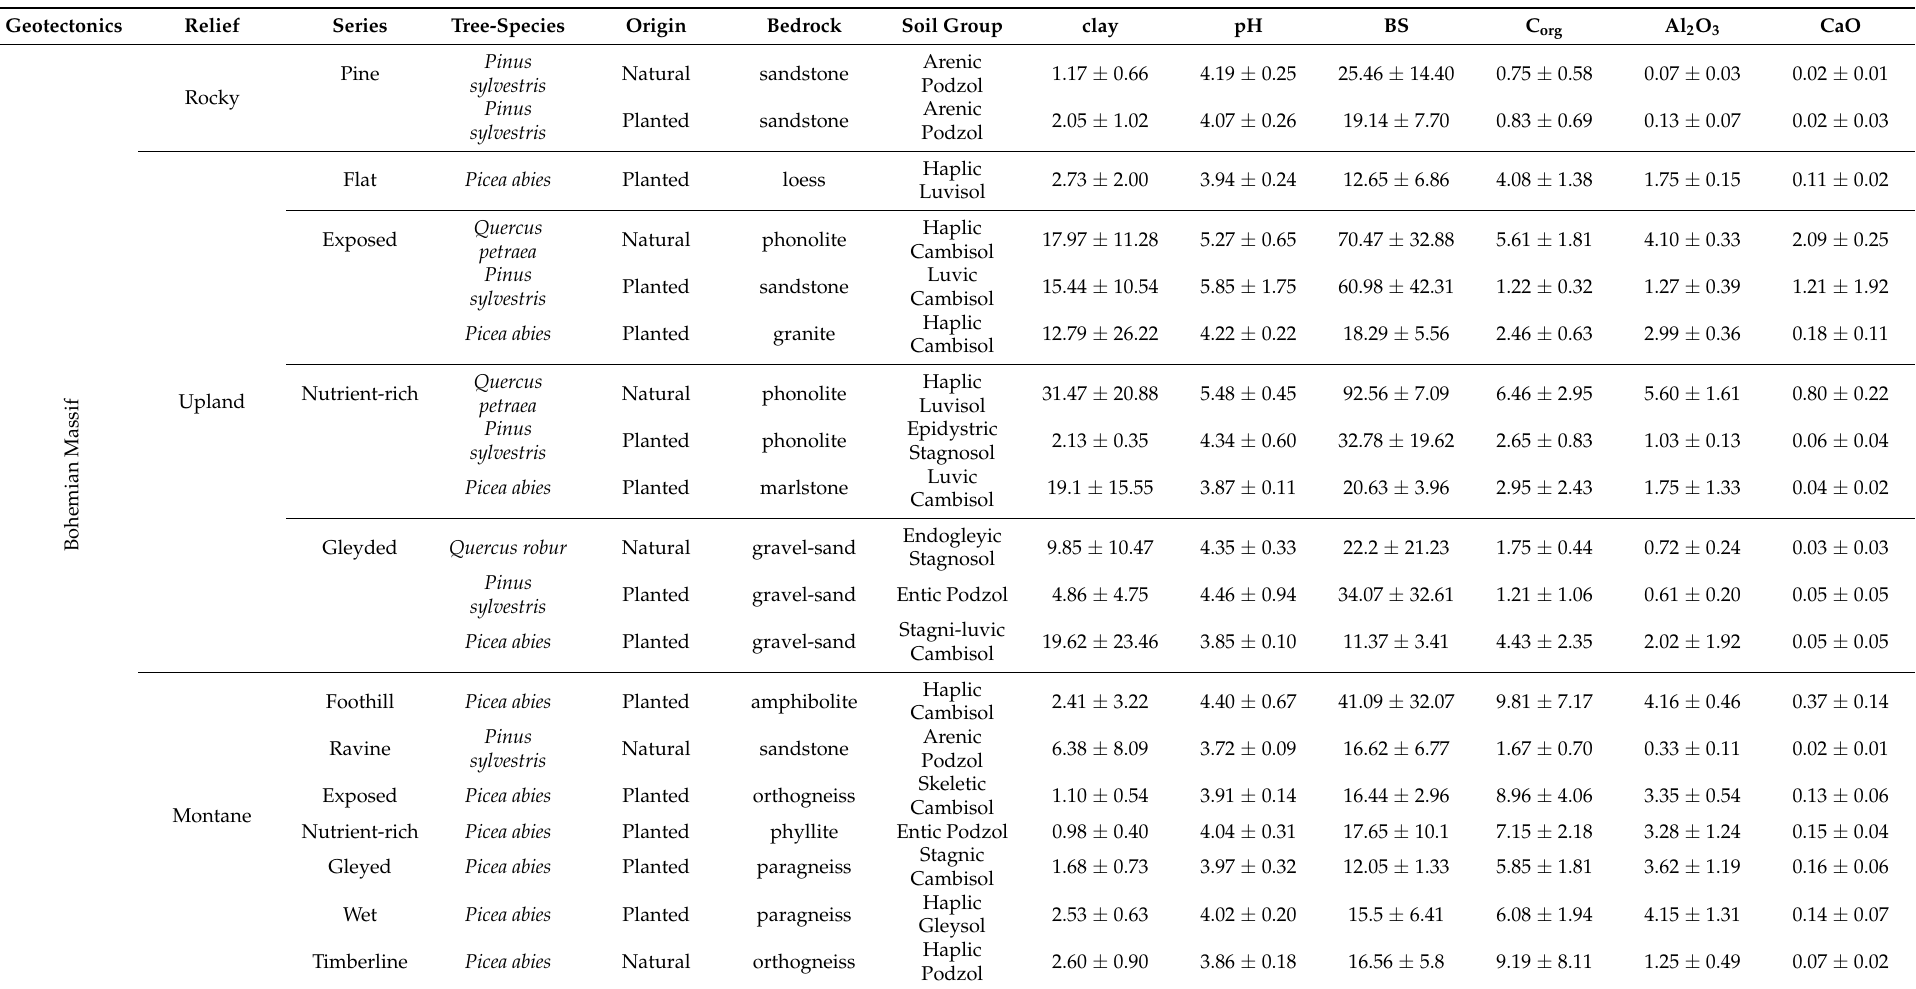
Table 3. Soil characteristics of sampled forest stand types in relation to bedrock type (mean ± standard